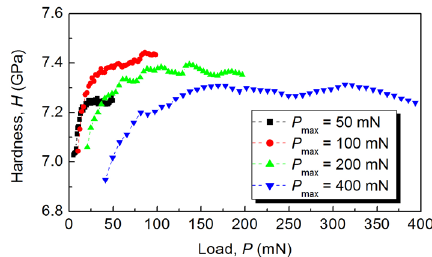
Fig. 5 Load dependency of the hardness calculated based on Eq. (5) using measured P /( h + h d ) 2 .